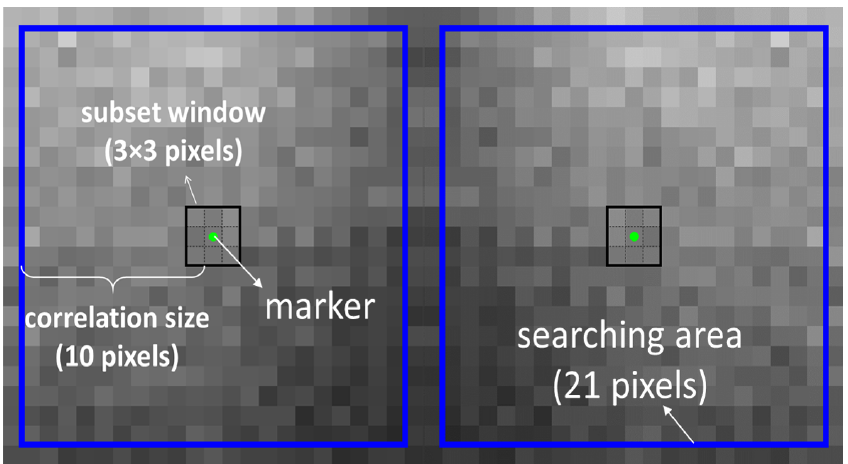
Figure 1. Schematic demonstration of definitions of subset window, marker, correlation size and searching area in the DIC